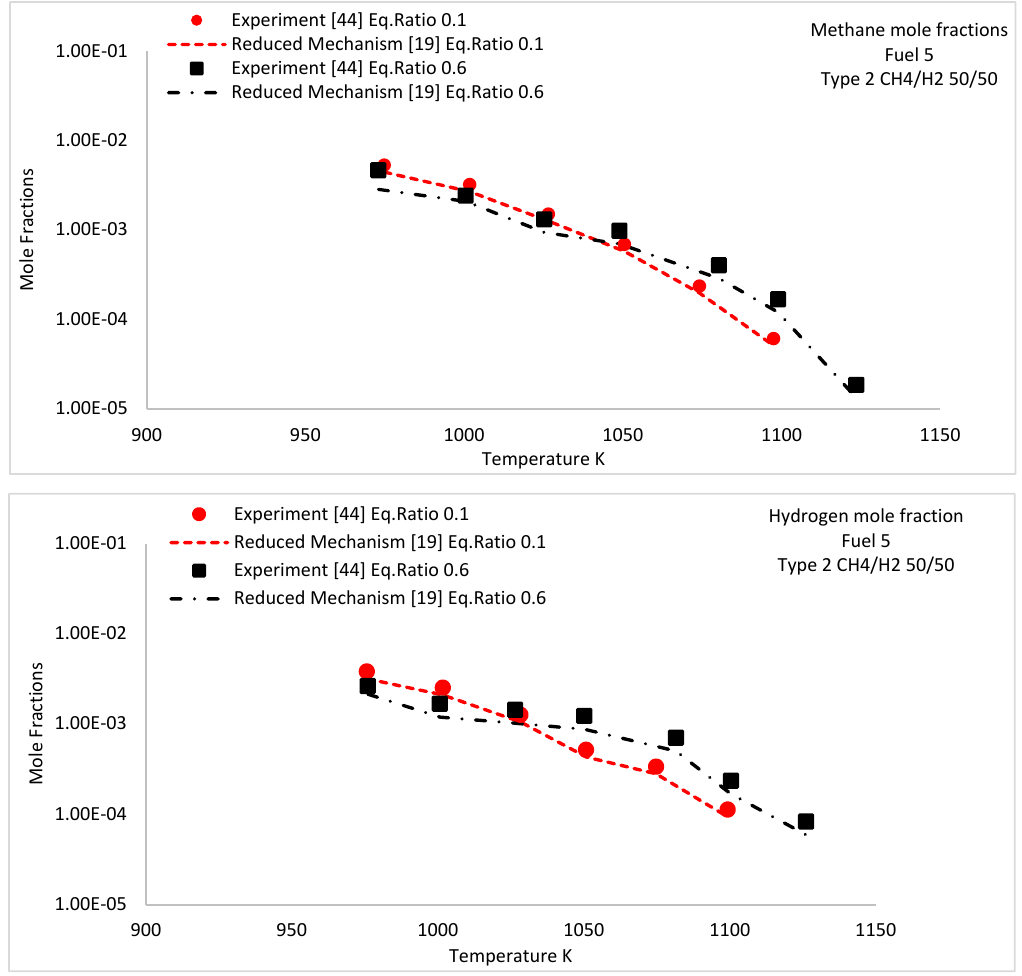
Figure 9. Comparison of the calculated CH 4 ( top ) and H 2 ( bottom ) profiles by using the reduced mechanism [19] and the experimental measurements from Reference [44] for CH 4 /H 2 50/50 mixture at pressure 1 bar, temperatures 950–1125 K and eq.ratios 0.1 and 0.6.